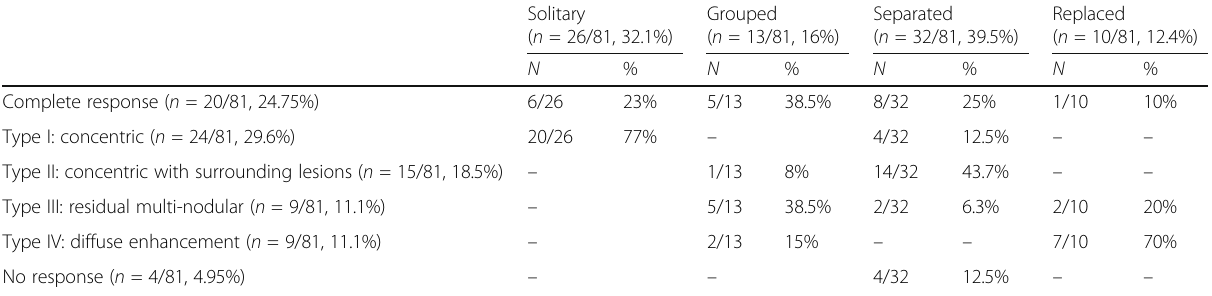
Solitary ( n = 26/81, 32.1%)